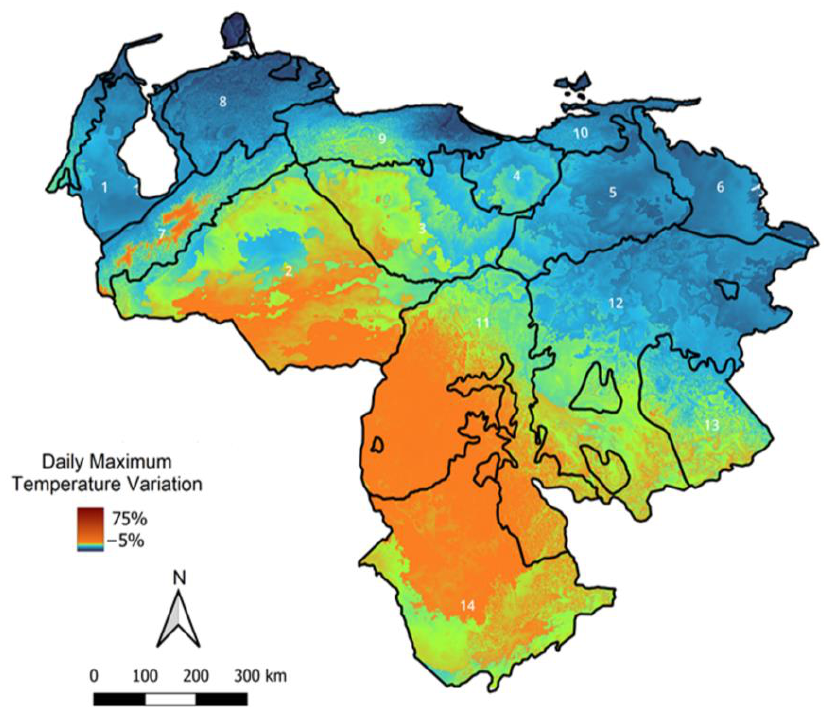
Figure 5. Maps of projected changes in daily maximum temperature between 1970–2000 and 2041–2060 in Venezuela, with the boundaries of the physiographic regions numbered as in Table 3.